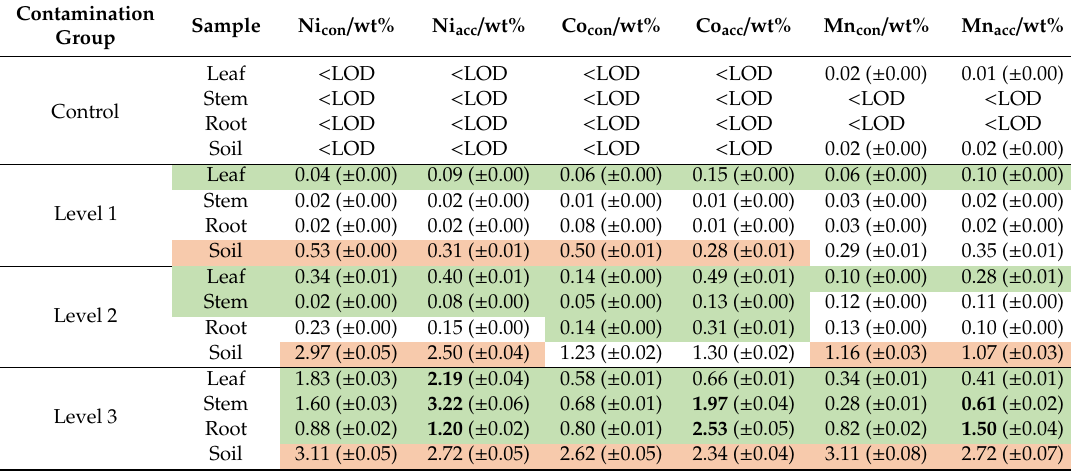
Table 2. Quantified concentrations of Ni, Co, and Mn in wt% by means of ICP-OES regarding dry matter of alyssum murale and dried soil after 20 days of contamination (con) and 26 further days of accumulation (acc). Measurable accumulation in plant tissues is highlighted in green, highest values in bold, and remediation of soils in red (n =